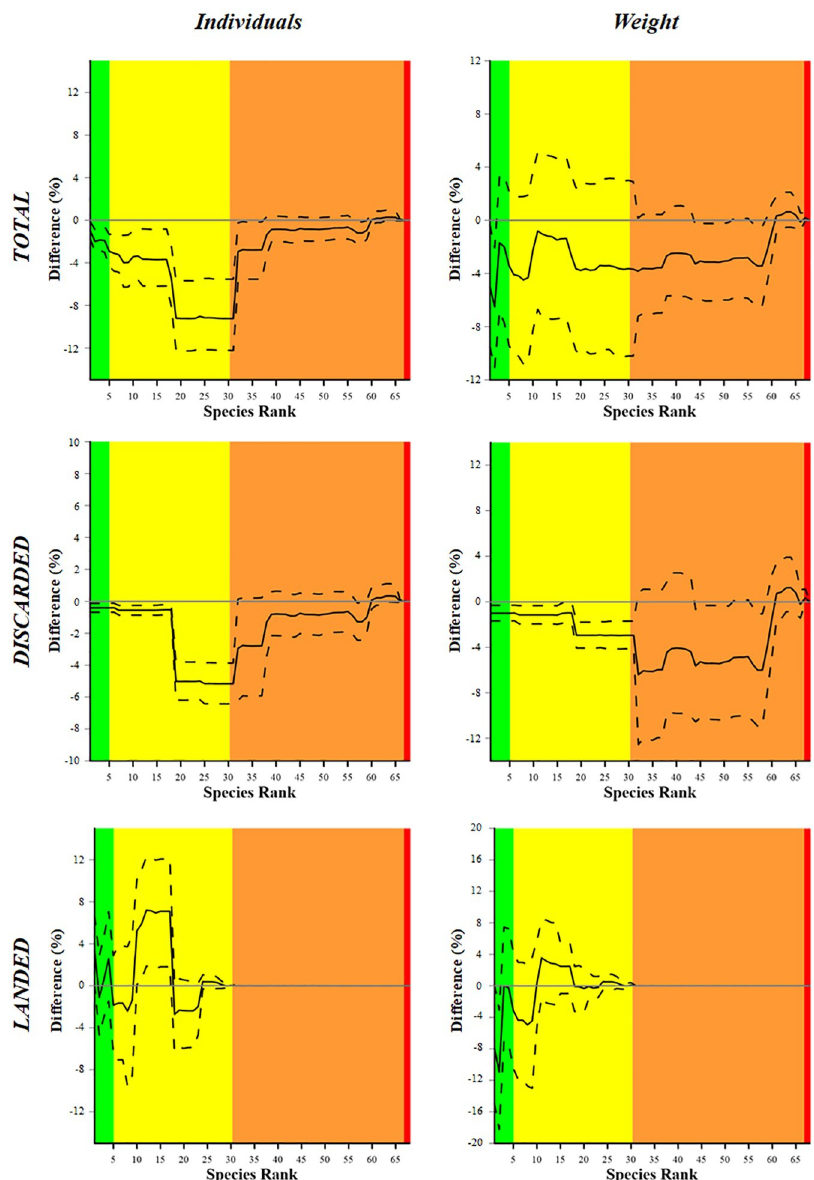
Fig 3. Delta plots resulting from the comparison of the cumulative dominance curves between the two codends tested (DM50, SM40) in both number of individuals (left column) and weight (right column). The curves (solid lines) with 95% CIs (dotted lines) are relative to the Total (top), discarded (middle) and landed (bottom) fractions. The 0 grey horizontal line represents an equal proportion between the two codends. The green, yellow, orange and red areas represent the target species, the bycatch species of commercial value, the species of no commercial value and the protected species, respectively. proportion of M . barbatus (S2), T . minutus capelanus (S5) and C . linguatula (S18) is present in SM40 catches than in DM50 catches.